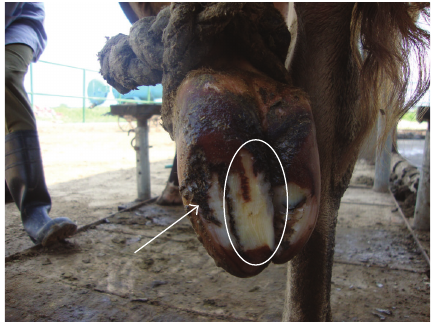
Figure 8: Overgrown sole and white line fissure.